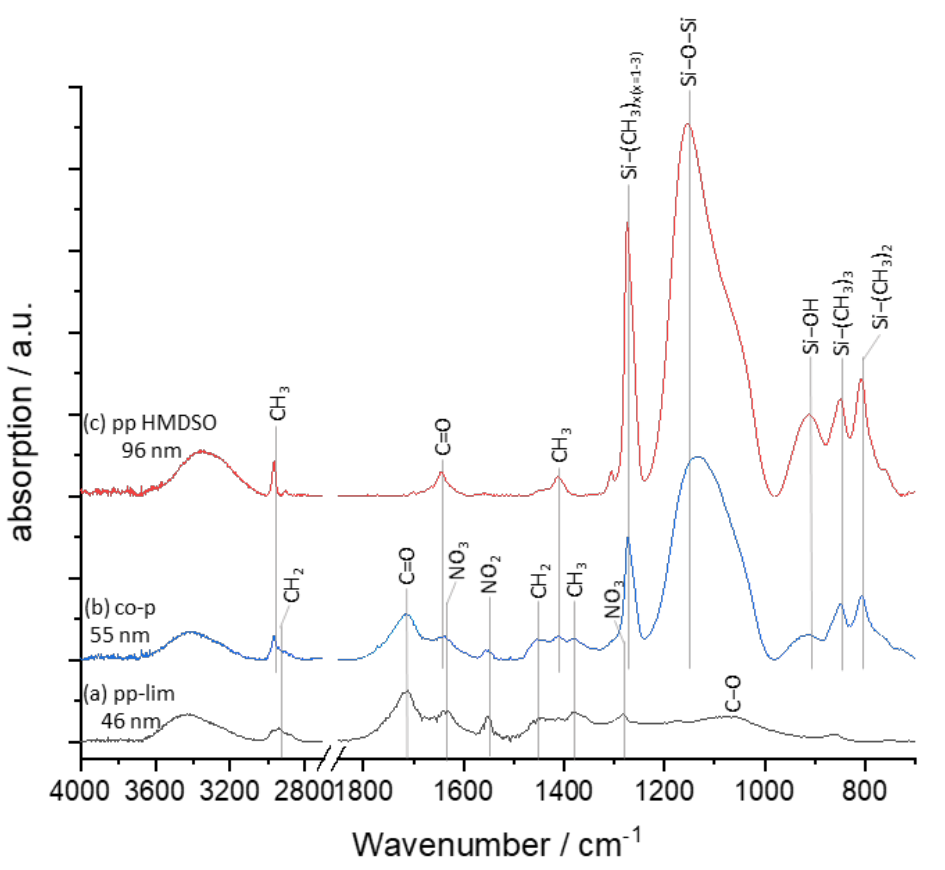
Figure 2. FTIR spectra of the pp with precursors: (a) lim (10 g · h − 1 ); (b) co-p (10 g · h − 1 HMDSO and 10 g · h − 1 lim); (c) HMDSO (10 g · h − 1 ). The FTIR spectra depict the coatings that were obtained with